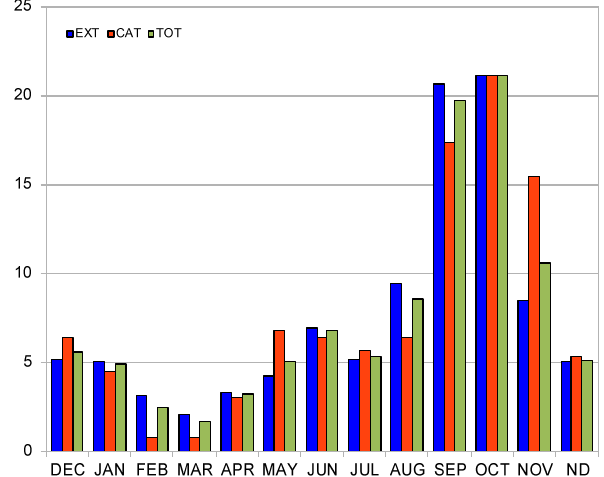
Figure 2. Temporal distribution of historical floods in Catalonia (1301–2012). Extraordinary (EXT), catastrophic (CAT) and total (TOT = EXT + CAT) floods. ND indicates floods with an unknown exact